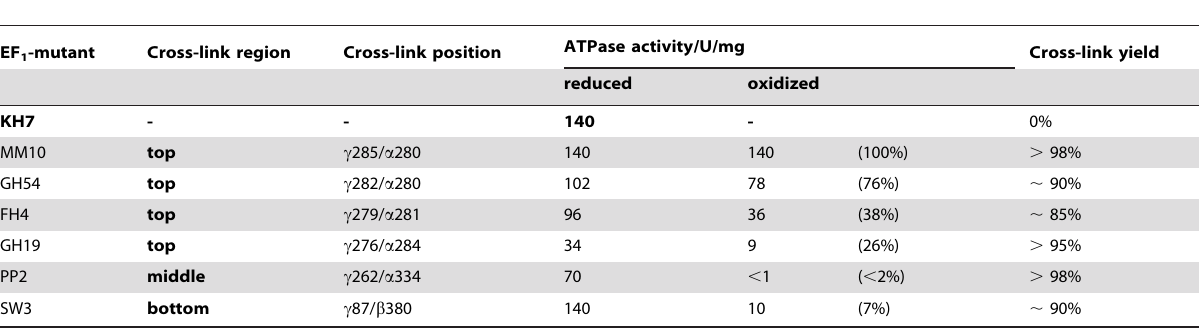
Table 1. Mutants and effects of cross-link